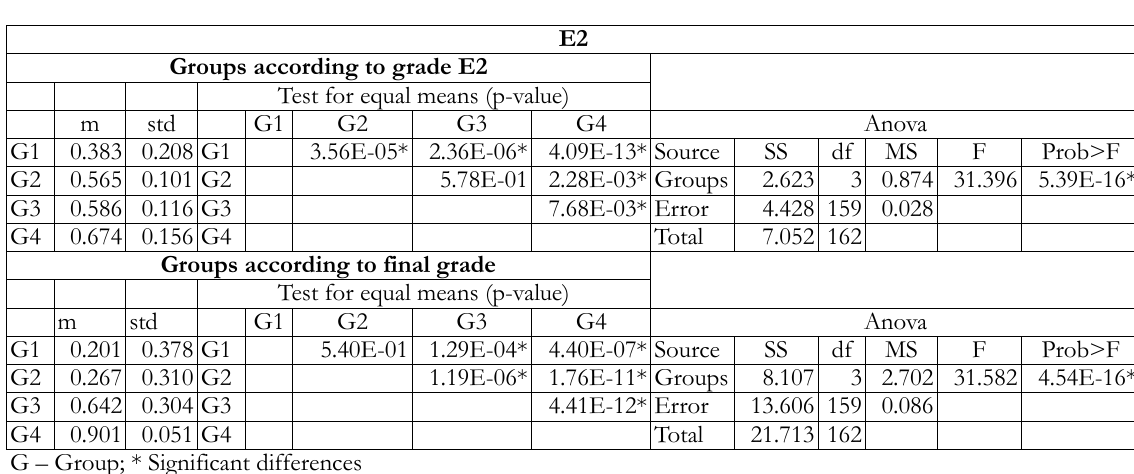
Table 5. Descriptive features of variable